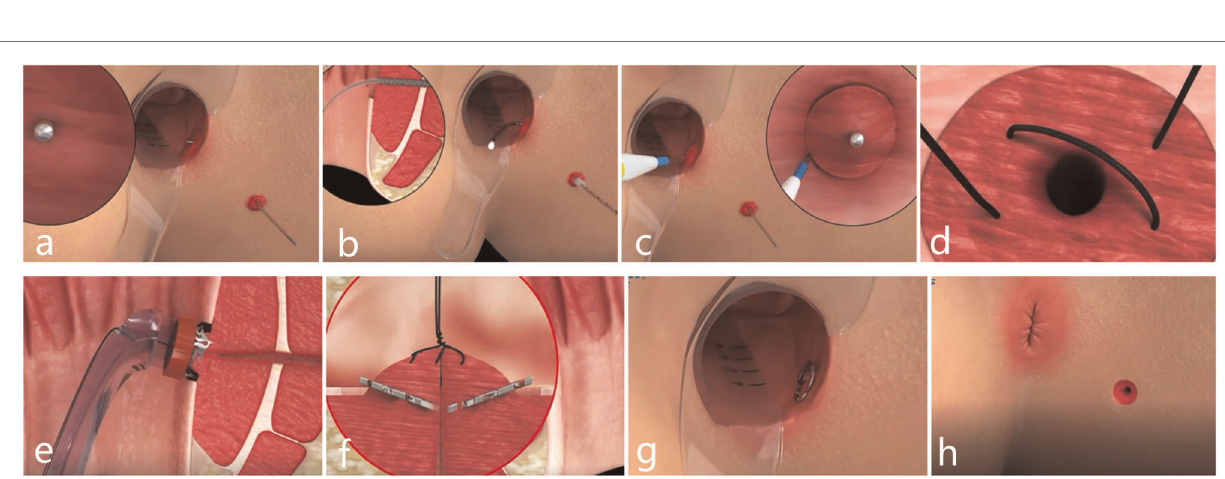
wound and the fi stula did not heal in 14.3% (3/21) patients ( Table 1 ). Three patients who did not heal had conventional surgery reperformed and eventually healed at 94, 103, and 108 days after primary surgery, respectively. Anorectal ultrasound also found that the healed fi stula emitted a stronger echo than the surrounding tissue when the surgeon considered the anal fi stula to be clinically healed.